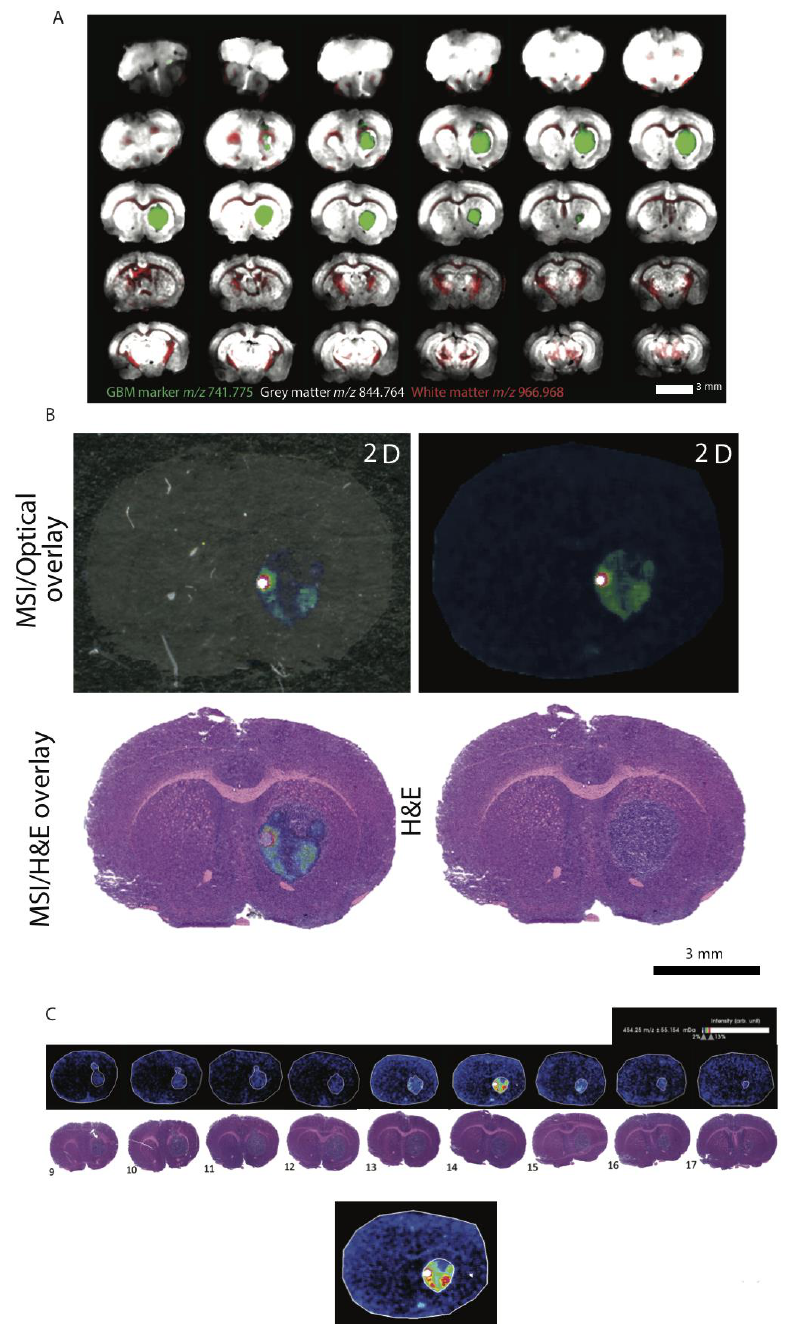
Figure 3. AZD2858 penetrates tumor tissue and is spatially distributed in GBM tumors in mouse brain sections. ( A ) Mouse brain tissue from BALB/c Nude mice intracranially injected with U87 cells and treated with AZD2858 were prepared for mass spectrometry imaging. Molecular markers for GBM, grey matter and white matter, were used for normal brain tissue and tumor tissue to allow enhanced visualization of tumor localization in sequential mouse brain sections. Sectioning of the full brain through 30 levels is shown. ( B ) MSI optical and H&E overlays were used to confirm AZD2858 co-localization with the tumor tissue. ( C ) Multiple tiers generated by MSI demonstrate a gradient of AZD2858 across the tumor. For the MSI/H&E overlay, image sections were selected to focus only on the GBM region in the brain (9–17 as described in ( A ) with the green marker), where AZD2858 was detected in higher